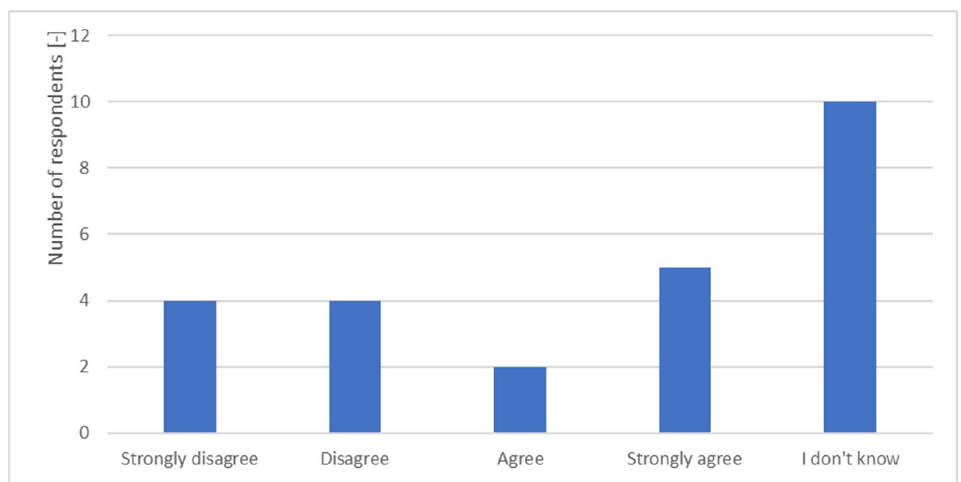
Figure 17. The reasons for the advantages of open systems of shared mobility over closed ones.